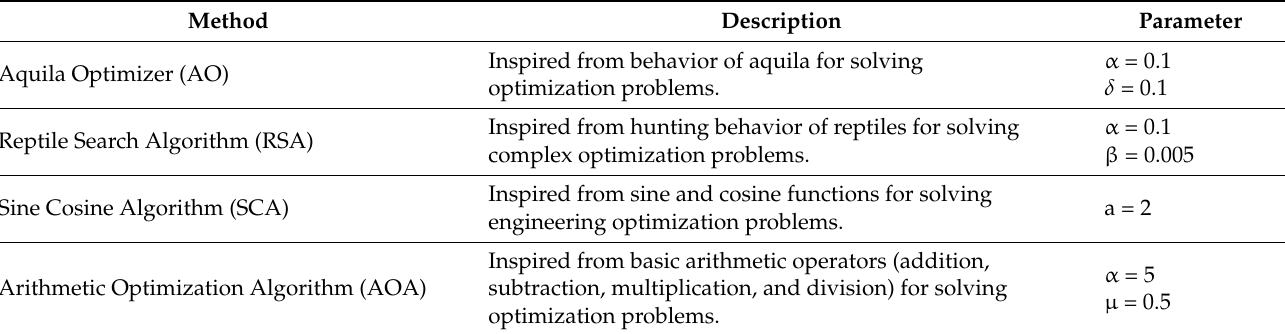
Table 5. Parameter settings of other